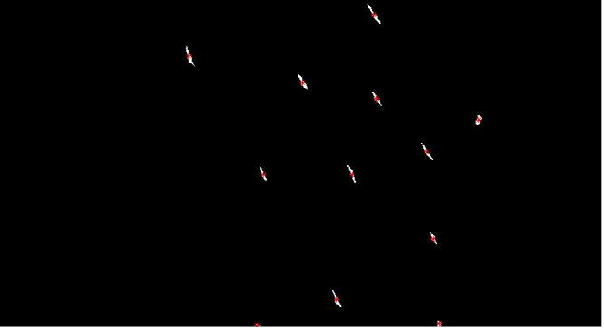
Fig. 12 UAVSAR Sub image U1 Output